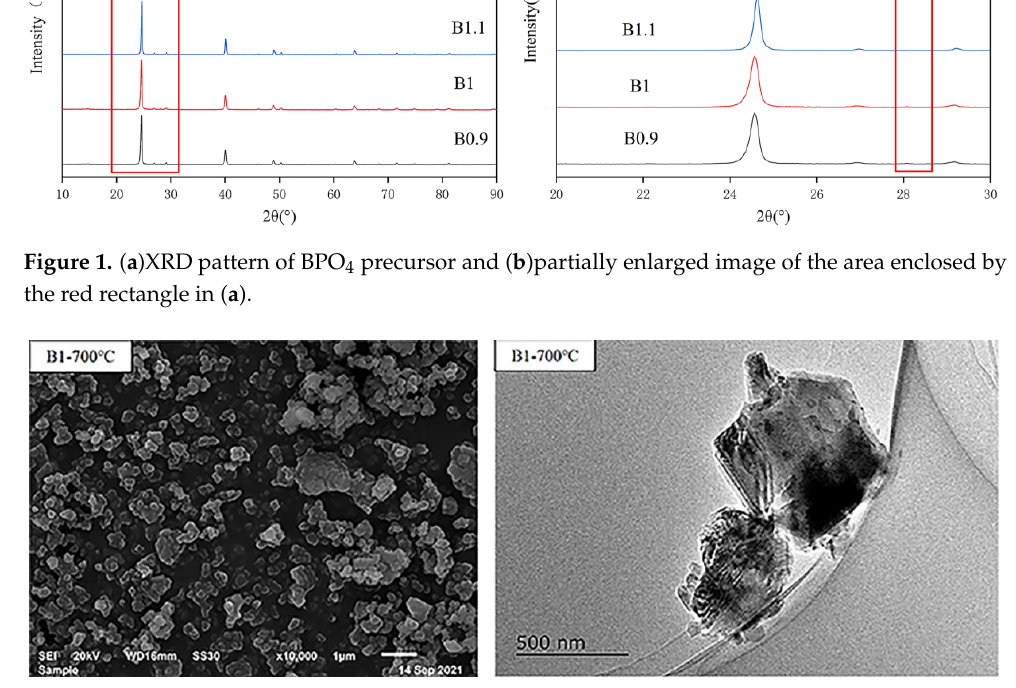
Figure 2. SEM graph and TEM graph of B1 precursor.